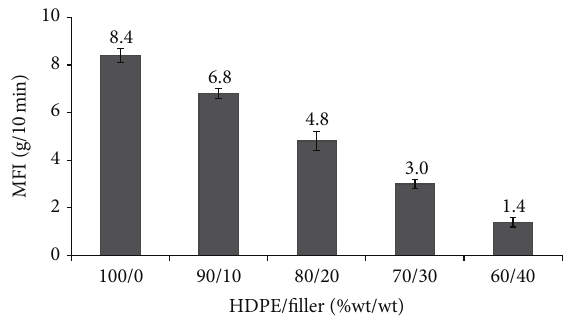
Figure 1: Melt-flow index of composites of renewable HDPE and sponge gourd filler.